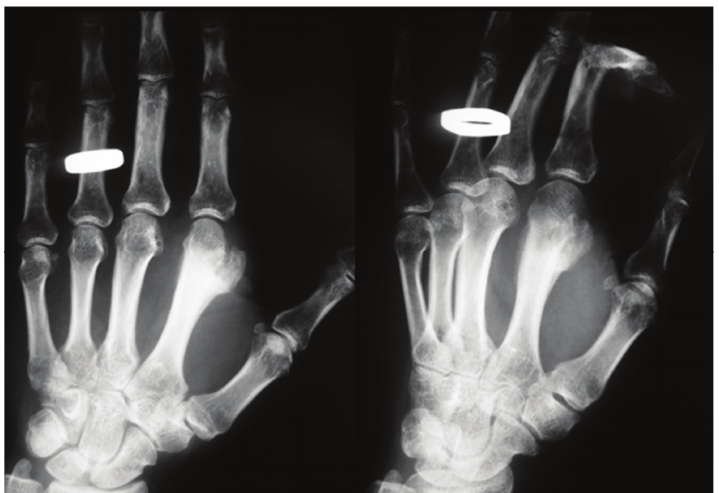
Figure 13: Case 2: an AP and oblique radiographs of the hand demonstrating a somewhat pedunculated mass arising from the lateral surface of the second distal metacarpal and resembling a focus of mature ossification with distinct medullary and cortical components.